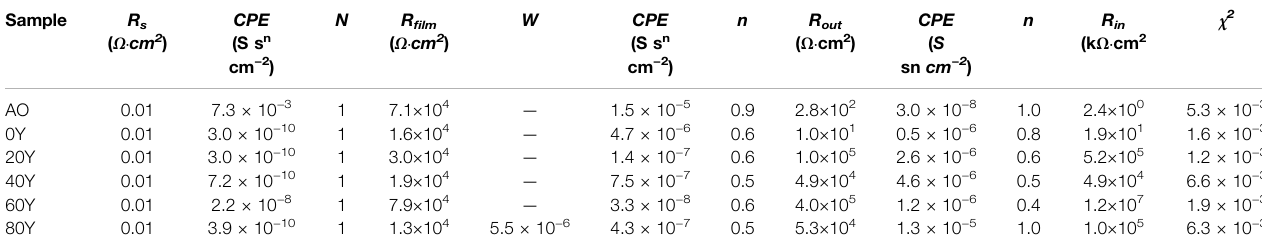
TABLE 3 | Fitted parameters of different specimens for the EIS spectrum. Sample